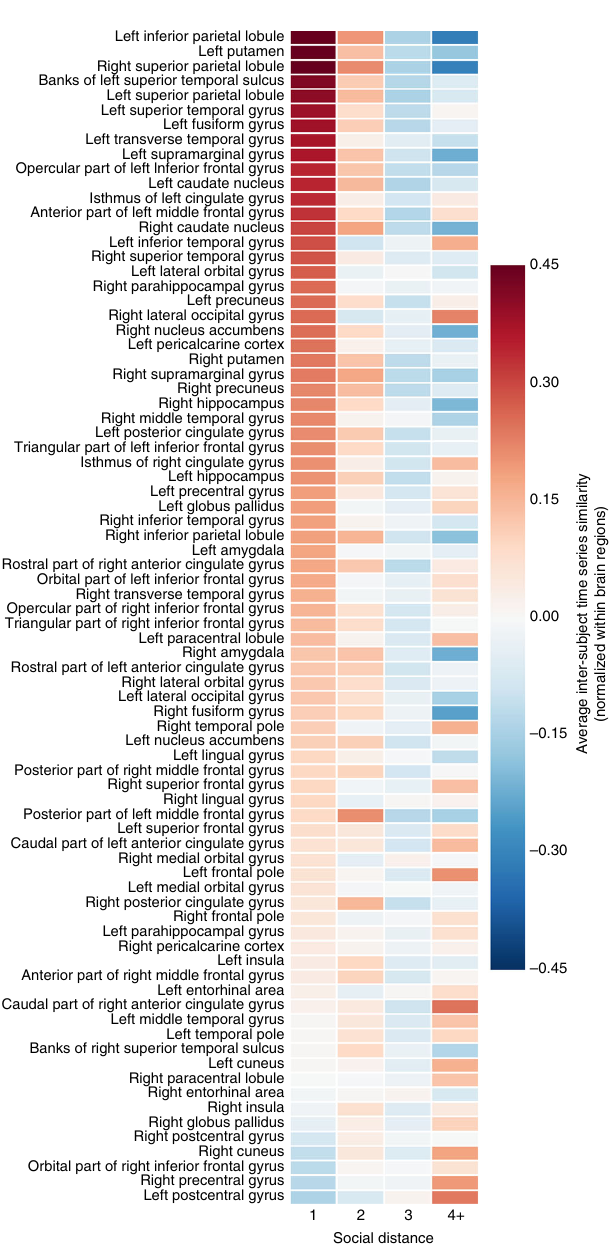
Fig. 3 Inter-subject similarities for each brain region at each level of social distance. Inter-subject correlations of neural response time series for each of the 861 dyads were obtained for each of 80 anatomical regions of interest (ROIs). In order to illustrate how relative similarities of responses in each brain region varied as a function of social distance, inter-subject time series similarities (i.e., Pearson correlation coef fi cients between preprocessed fMRI response time series) were normalized (i.e., z -scored across dyads for each region) prior to averaging across dyads for each brain region within each social distance category. Warmer colors indicate relatively similar responses for a given brain region; cooler colors indicate relatively dissimilar responses for that brain region. Please note that because similarities have been normalized across dyads for each brain region, values depicted in this fi gure should be compared across social distance levels for each brain region, rather than across brain regions within or across social